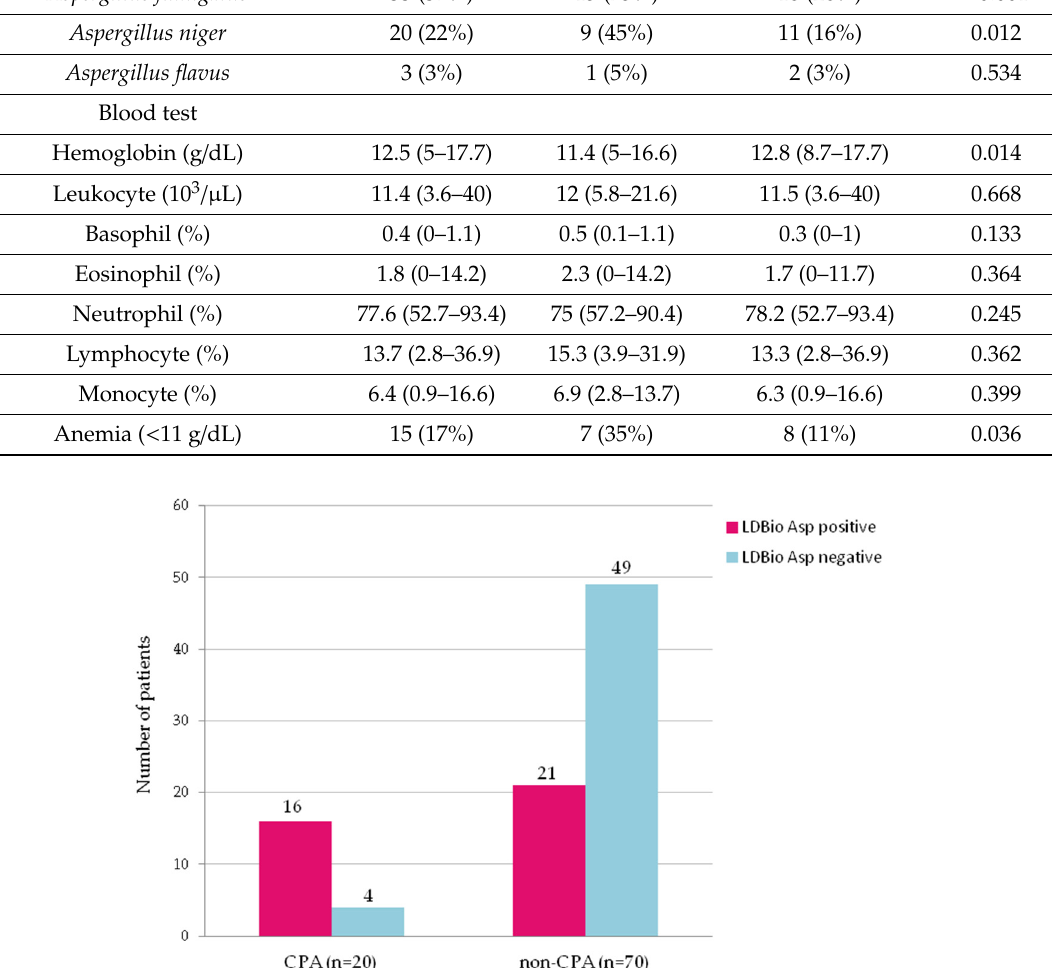
Figure 2. Radiological findings of chronic pulmonary aspergillosis (CPA) in a 51-year-old male patient two months after completion of TB treatment. A large cavity with aspergilloma (black arrows) of the left upper lobe in chest x-ray ( A ) and computed tomography scans ( B,C ).